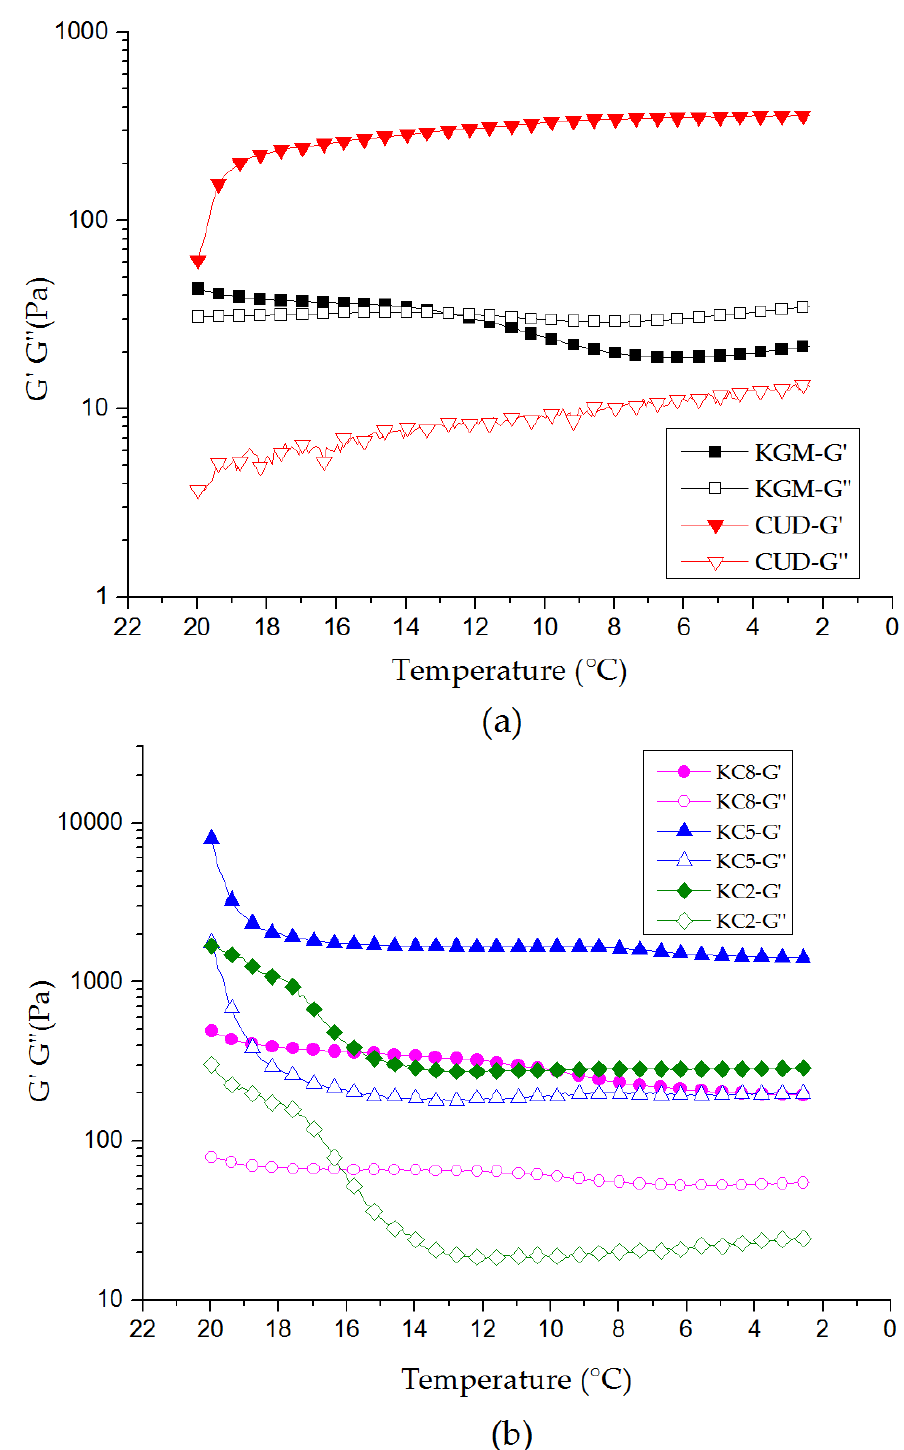
Figure 6. Curves showing the variations in G’ and G” of ( a ) KGM and CUD and ( b ) KGM/CUD blend systems with decreasing temperature during the cooling process (20–2 °C).